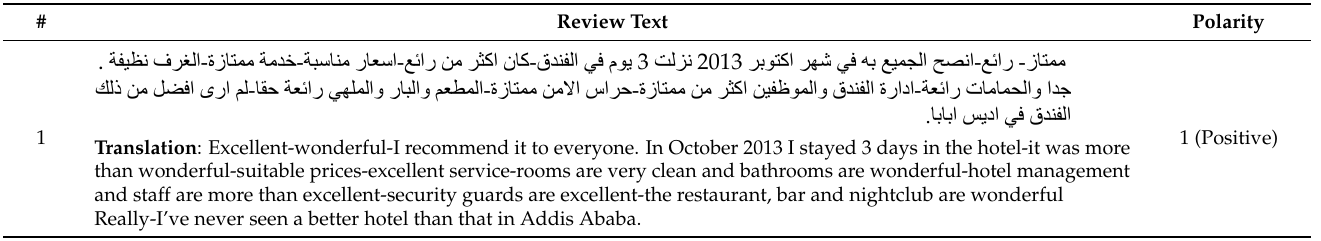
Table 2. Sample hotel review from ElSahar and El-Beltagy dataset.